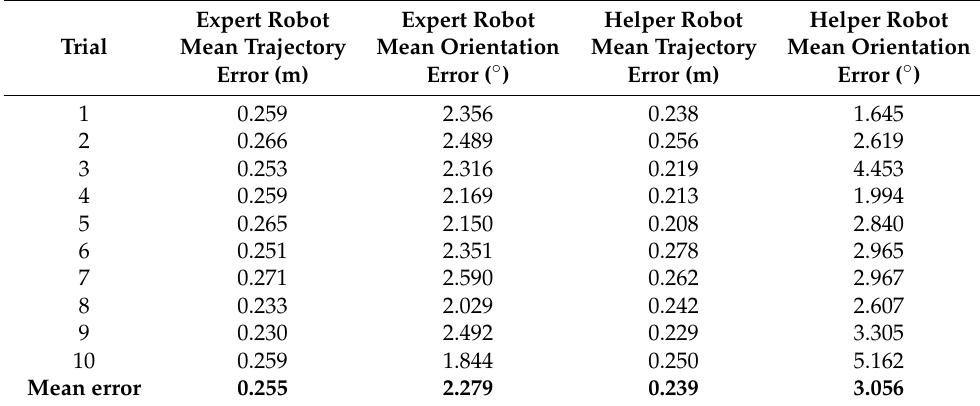
Table 1. Position and orientation errors for the expert and helper robots for the first test path.